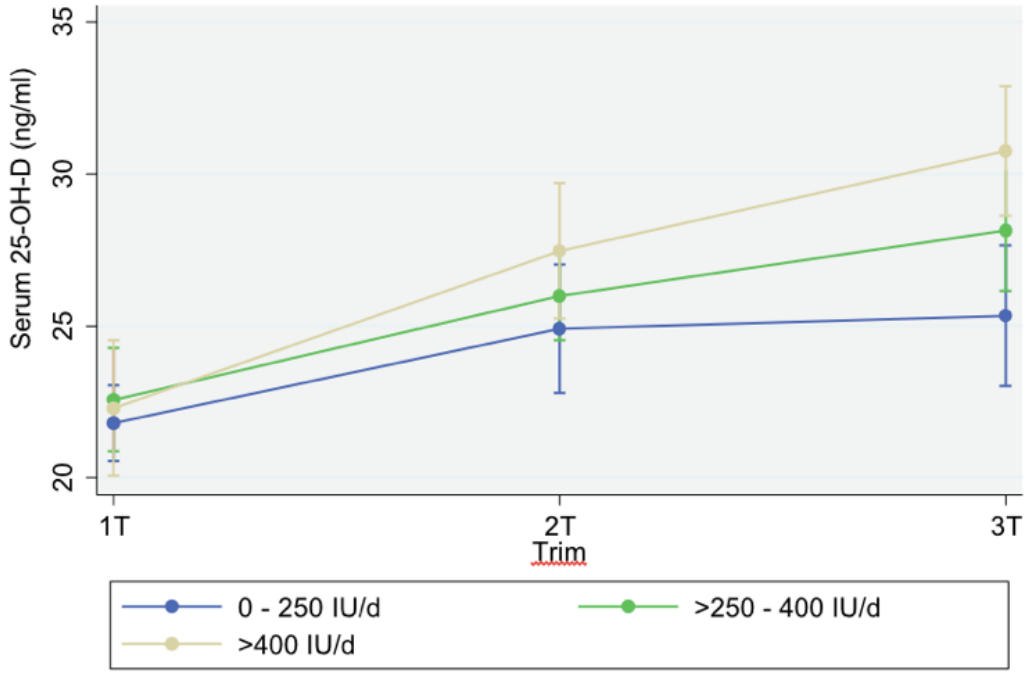
Figure 3. Mean vitamin D concentrations throughout pregnancy according to supplementation doses, season, pregestational weight status, parity, and age. Marginal means and 95% confidence intervals. T1, first trimester; T2, second trimester; T3, third trimester. General mixed-linear model, adjusted by season, pregestational weight status, parity, and age. *Significantly higher concentrations in T3 in the >400 IU/day group ( p = 0.003).